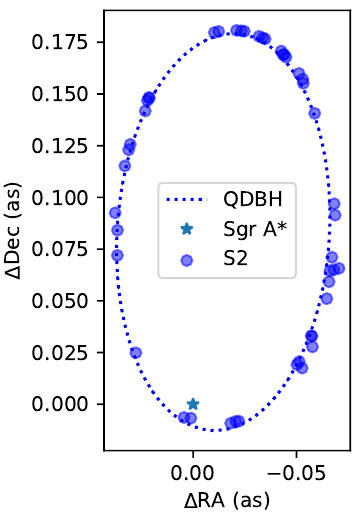
units 4.07 × 10 6 M (cid:12) ) within 68% confidence and M = 1.029 + 0.002 level, respectively.